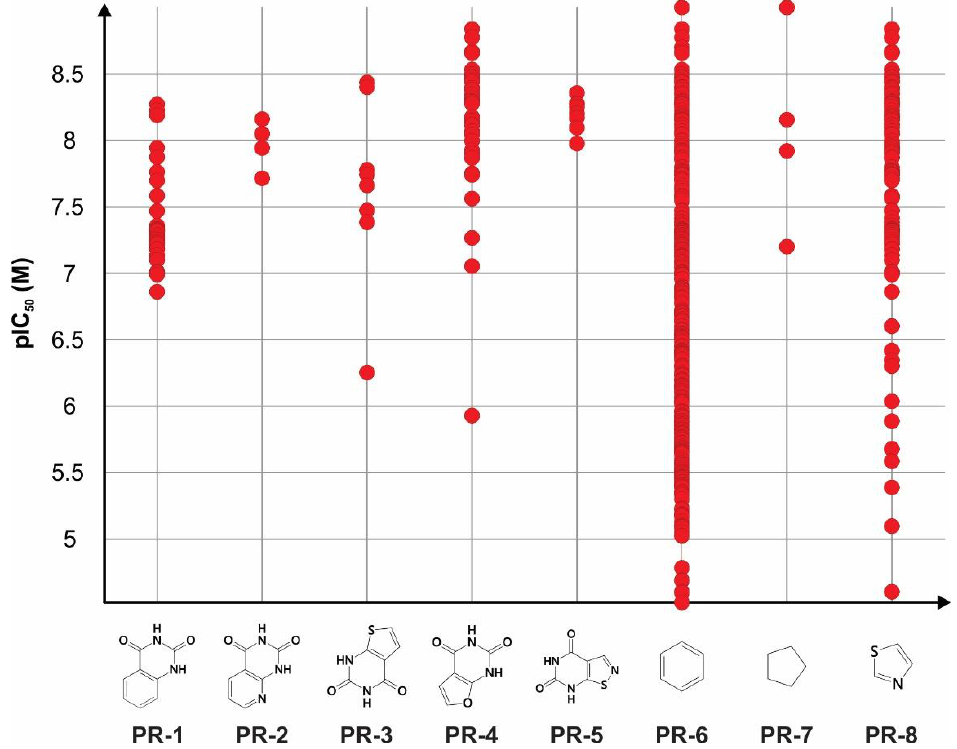
Figure 3. Plain rings contained by compounds with significantly higher TRPA1 inhibitory activity using statistical comparison of mean pIC 50 (M) values.